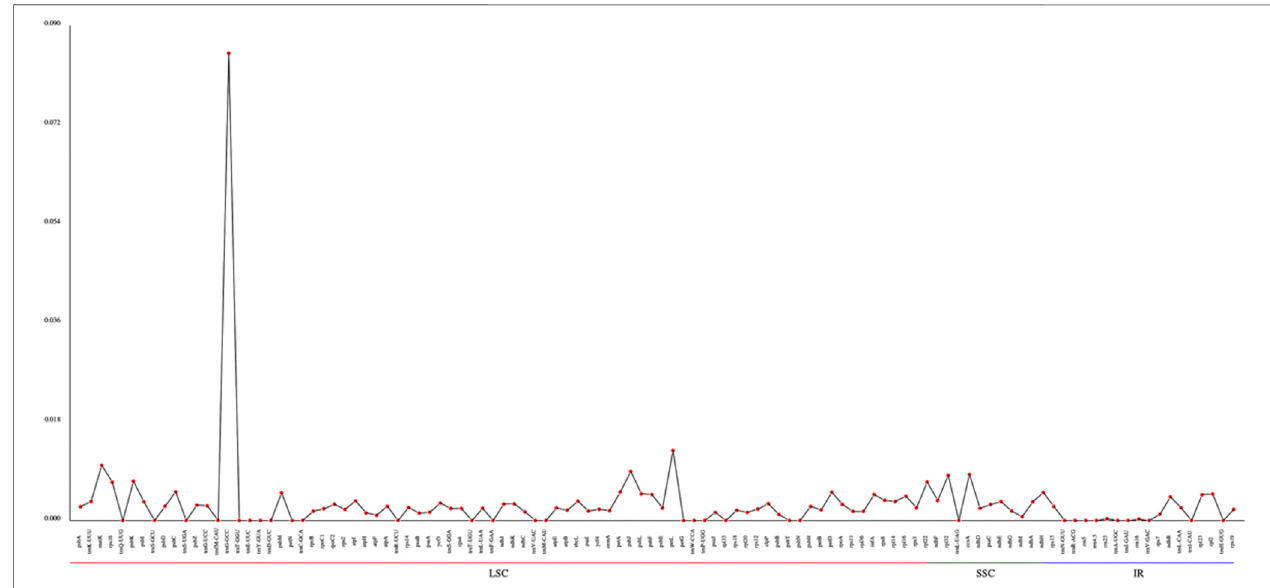
FIGURE 6 | Line graph showing the gene PI value. X -axis: name of the gene. Y -axis: value of PI.